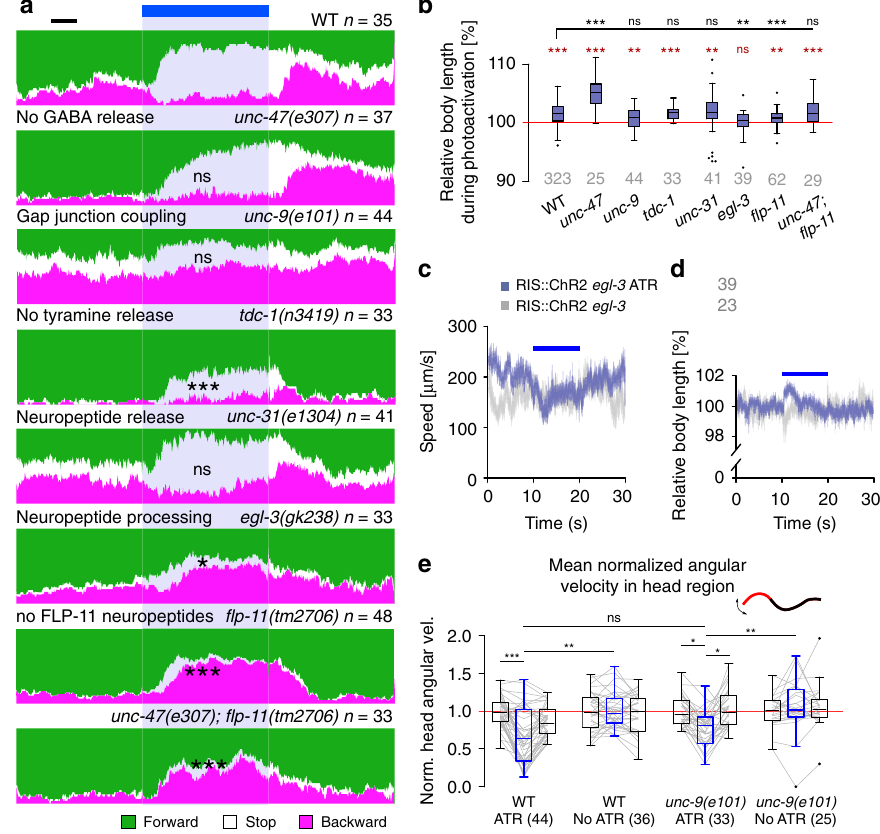
Fig. 4 The stop phenotype induced by RIS photoactivation requires GABA and neuropeptide signaling. a Animal locomotion analyzed before, during, and after photoactivation of RIS (in lite-1(ce314) background, to eliminate unspeci fi c photophobic responses) and the proportion of animals in distinct state (forward (green), stop (white), reversal (magenta)) deduced from the animal velocities is represented in color, over time, across all animals analyzed (number of animals and genotypes indicated above each data set). Signi fi cant change in stop proportion during RIS photoactivation versus WT indicated; blue bar and blue shade: illumination period; scale bar: 2 s. b Relative body elongation during RIS photoactivation; box plot with Tukey whiskers, numbers of animals, and genotypes are indicated below. c , d Mean ± SEM locomotion speed ( c ) or body length ( d ) before, during, or after photoactivation of RIS::ChR2 (blue bars) compared in egl-3(gk238) mutants raised with or without ATR. Number of animals depicted in gray. e Mean normalized angular velocity in anterior quarter of the animal for WT and unc-9(e101) mutants expressing RIS::ChR2, with and without ATR. Box plot with Tukey whiskers. *** p ≤ 0.001; ** p ≤ 0.01; * p ≤ 0.05; ns: non-signi fi cant; statistical signi fi cance tested by ANOVA, Kruskal – Wallis with Dunn ’ s Multiple Comparison Test in ( a ; black, versus WT in b , e ) or Wilcoxon Signed Rank Test, versus no body length change (red, in b